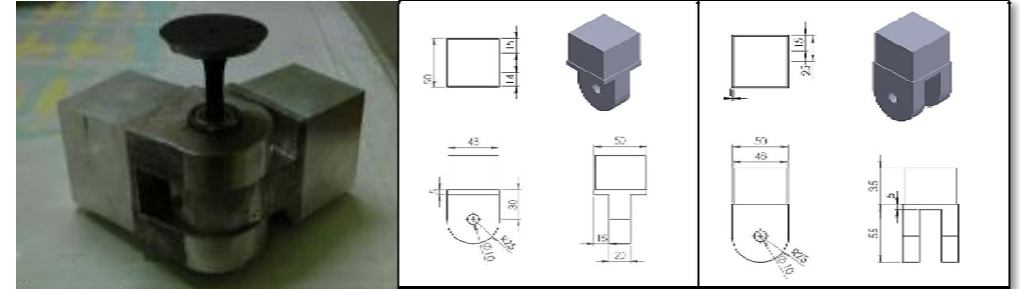
Fig. 4. Joint Connect The Arm .